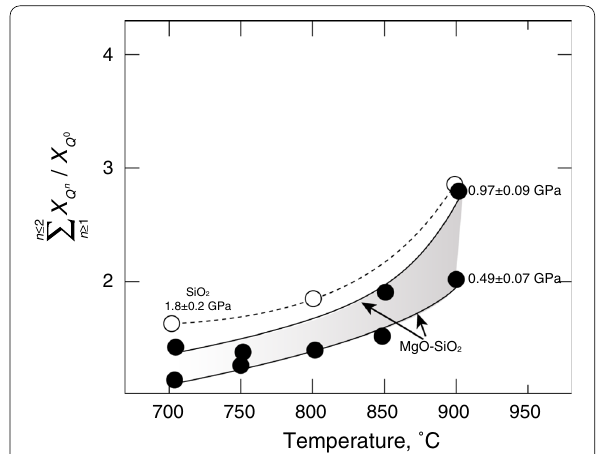
Fig. 16 Q . n speciation in SiO 2 –H 2 O and MgO–SiO 2 –H 2 O fluid as a function of temperature at the pressures indicated on individual curves. Modified after Mysen et al.